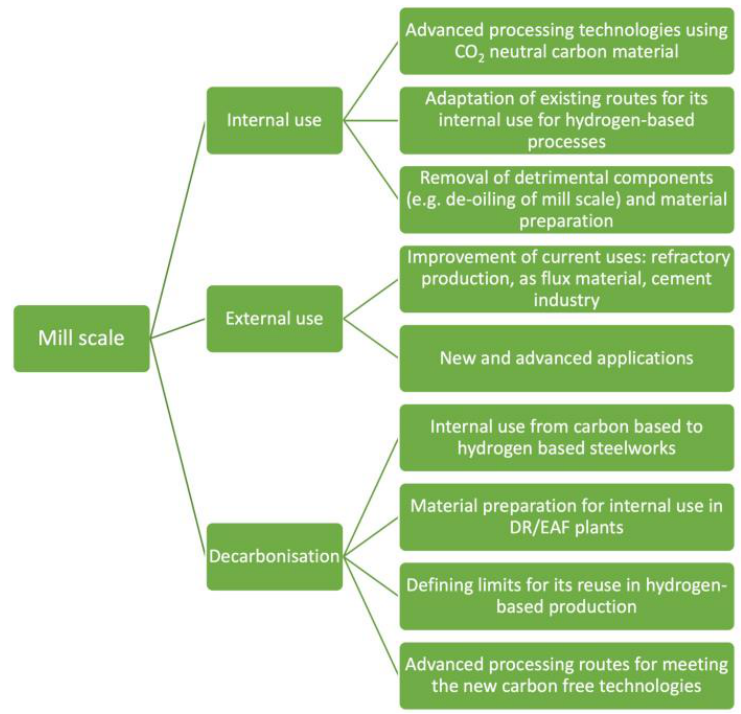
Figure 11. Future research needs on mill scale.